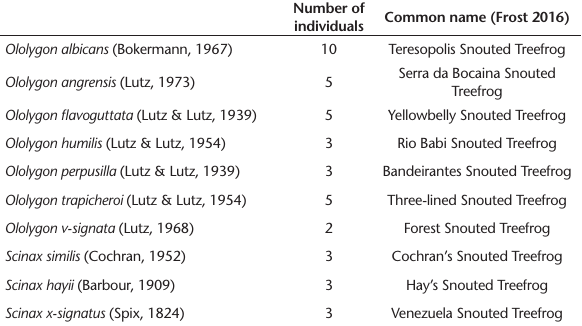
Table 1. List of individuals used in this